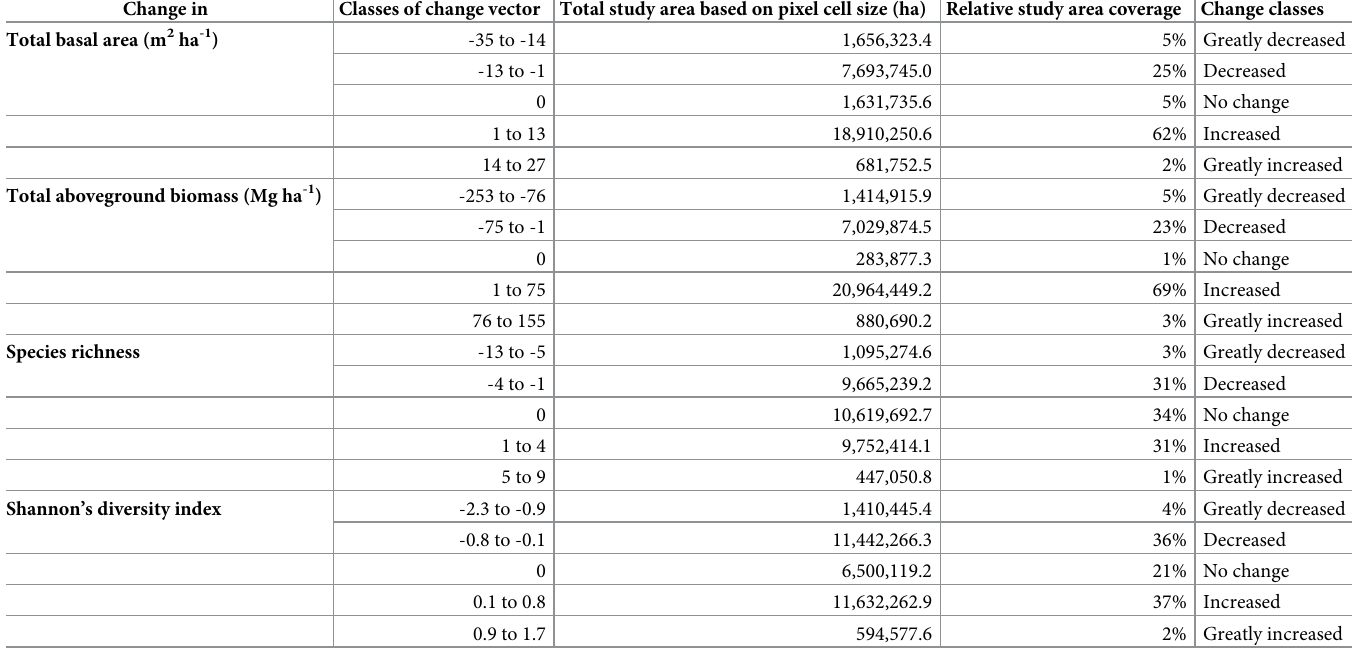
Table 4. Change classes for total basal area, total aboveground biomass, and species diversity across the plots between 2004 and 2011, where 2004 and 2011 are the centroid-year of first (1997–2010) and last (2003–2018) inventory intervals, respectively (N = 1,432). Change in Classes of change vector Total study area based on pixel cell size (ha) Relative study area coverage Change classes Total basal area (m 2 ha -1